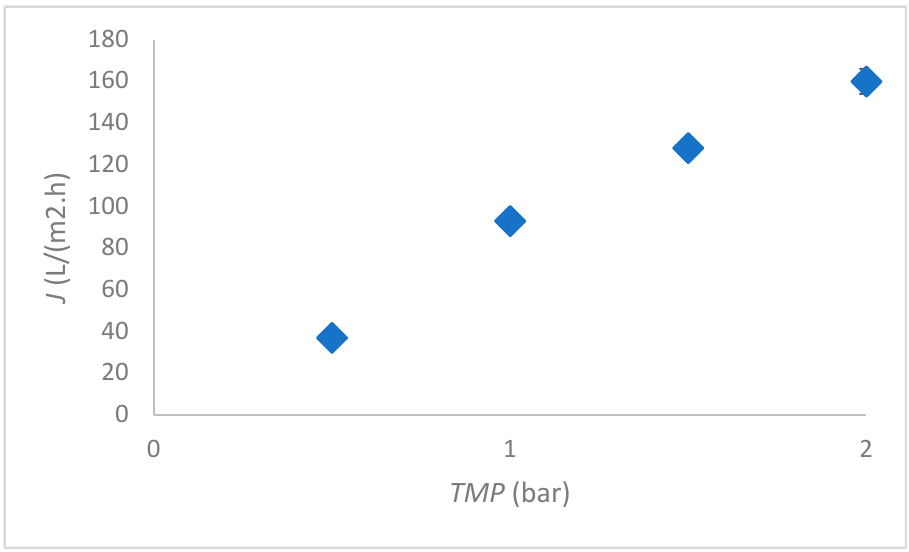
Figure 2. Flux dependent on TMP for the ceramic membrane.